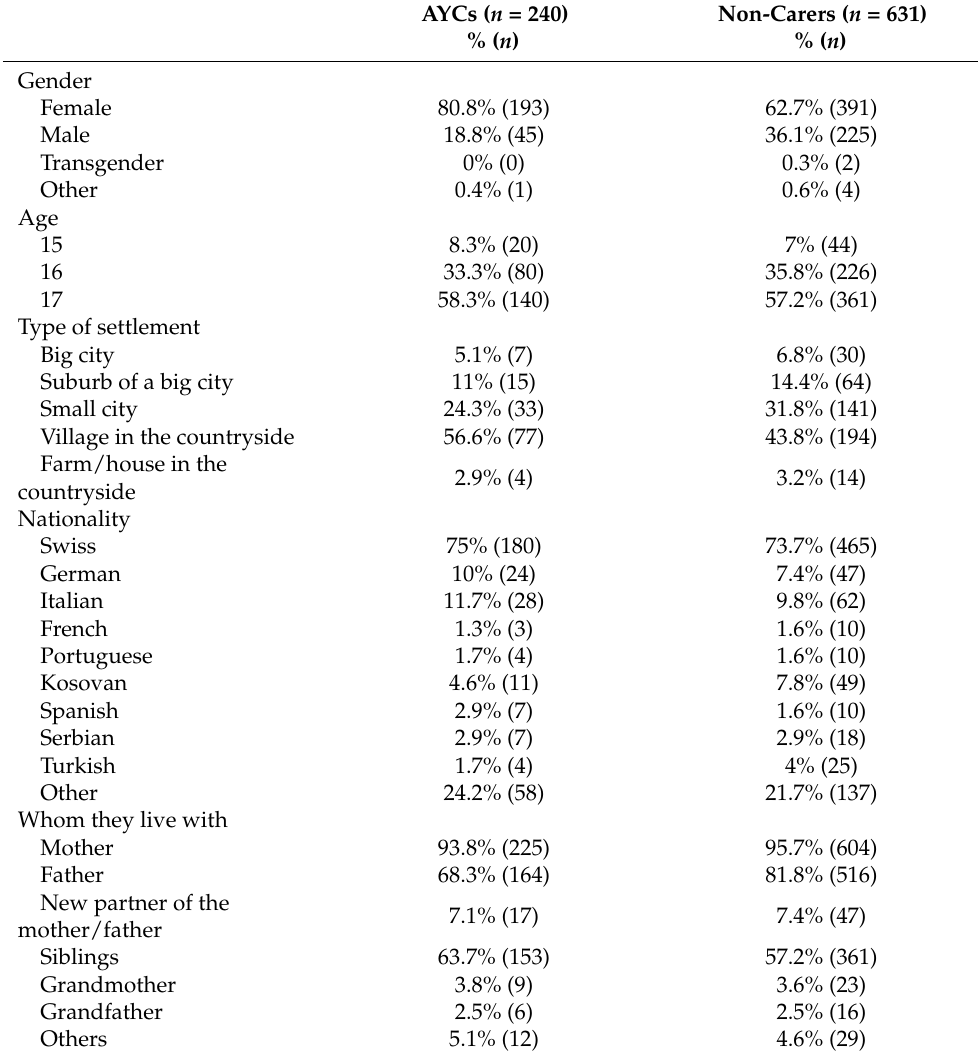
Table 1. The sociodemographic characteristics of the